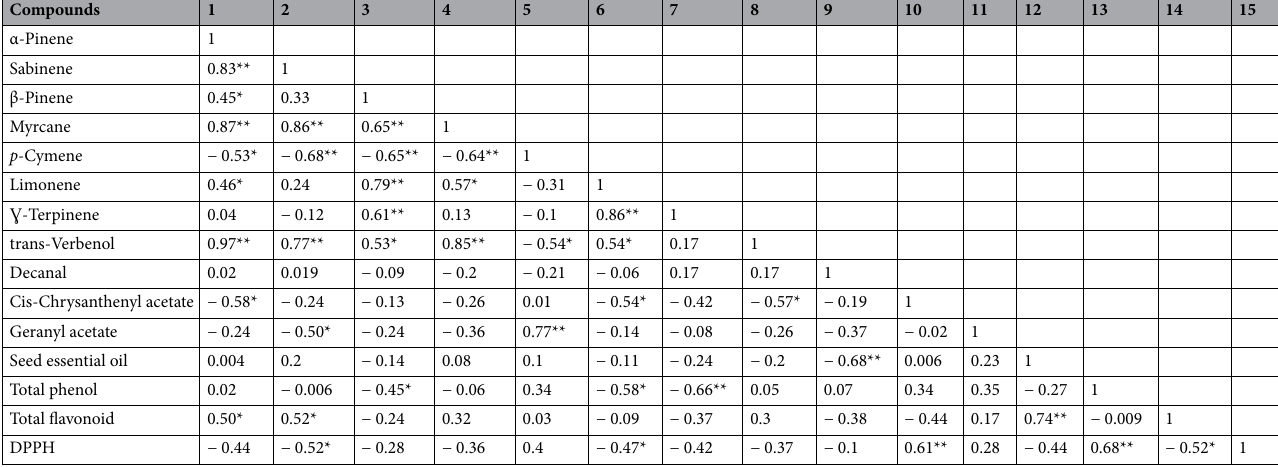
Table 5. Pearson correlation coefficients between major essential oil compounds of fruit essential oil, total phenol, total flavonoid and DPPH of eight Moshgak population severe water stress conditions. *Significant at P ≤ 0.05; **significant at P ≤ 0.01.